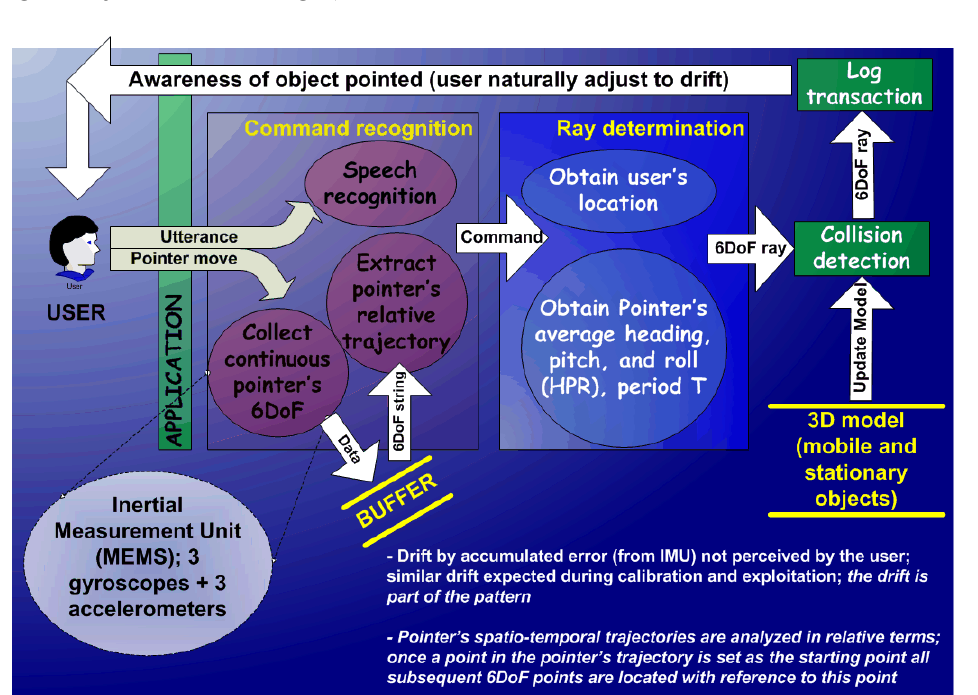
Figure 1. Functional flow diagram for natural and intuitive interface for